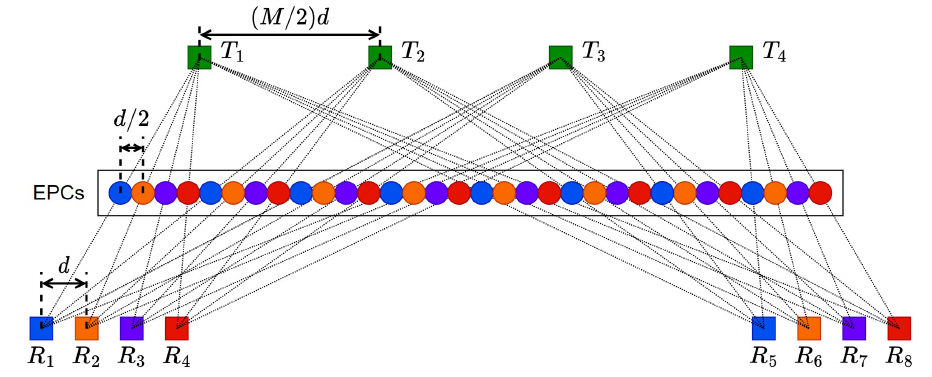
Figure 4. An illustration of a traditional array arrangement.